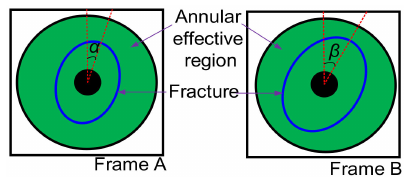
Figure 6. The relative motion of two front view borehole-wall images.